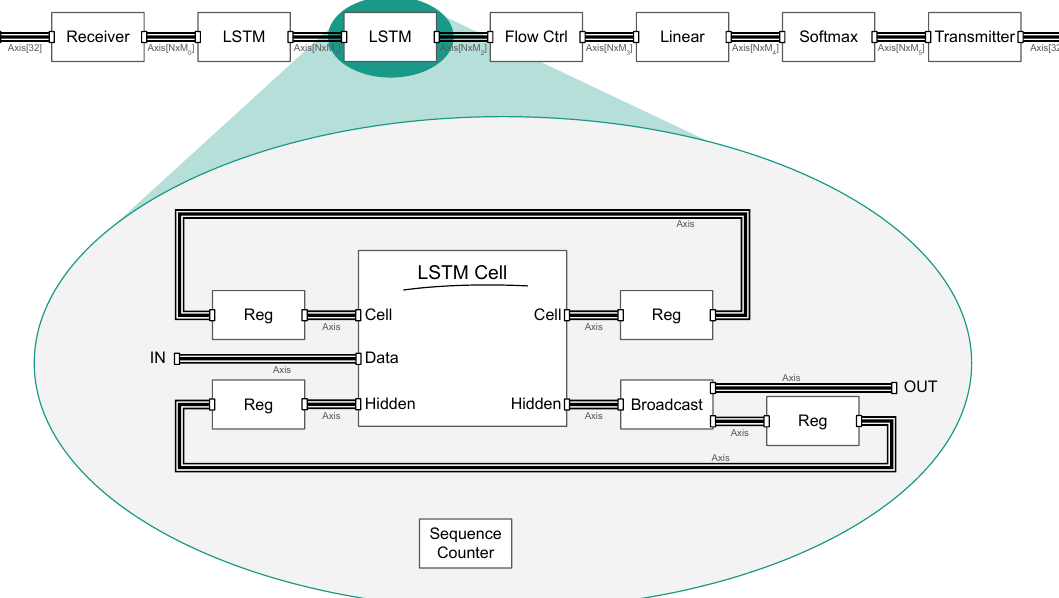
Figure 8. Field-programmable gate array (FPGA) network implementation schematic. N —bit width, M —# of elements in a feature